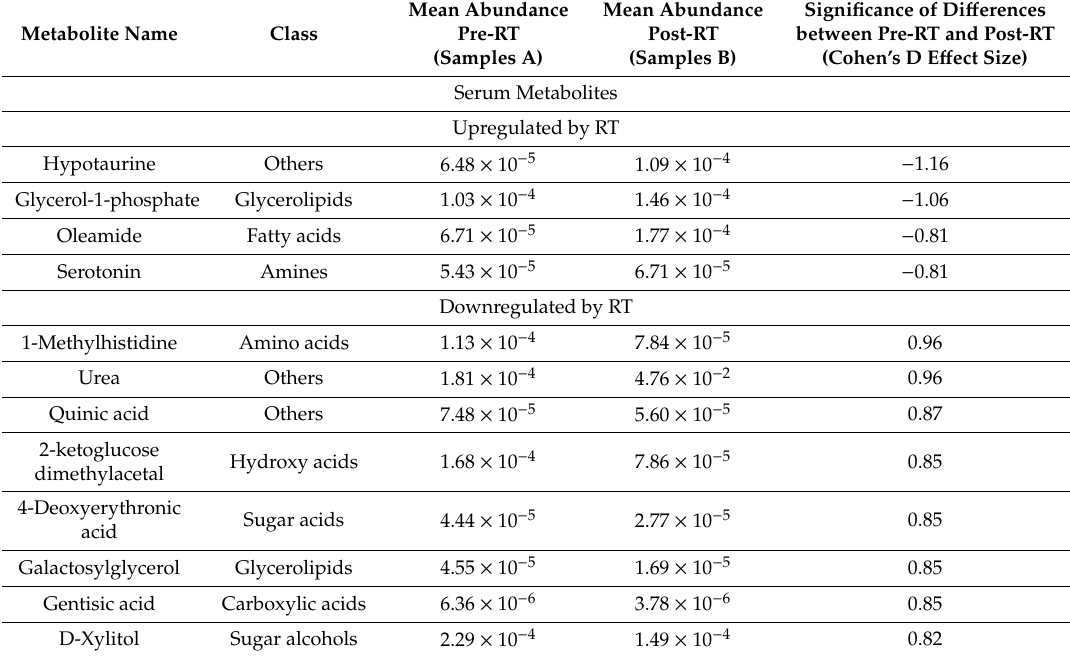
Table 2. Metabolites that were a ff ected by radiotherapy. Listed are compounds where di ff erences between paired pre-RT (samples A) and post-RT (samples C) specimens showed a large e ff ect size (Cohen’s d e ff ect size ≥